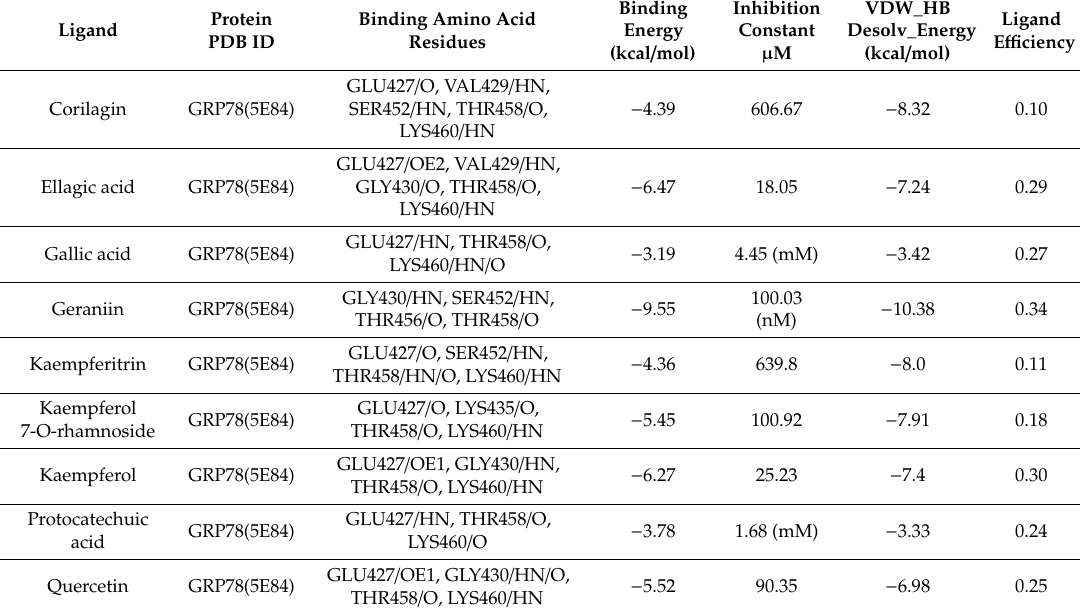
Table 4. The binding details of polyphenols present in Geranii Herba ( Geraniaceae ) with glucose- regulated protein 78